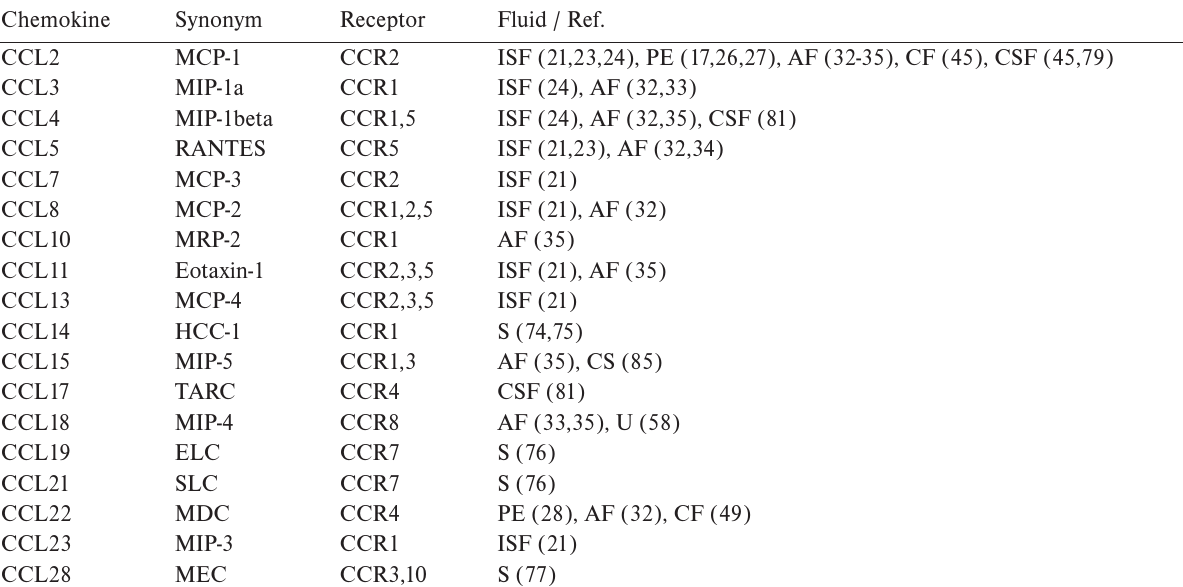
Table 1. CC Chemokines in tumor proximal